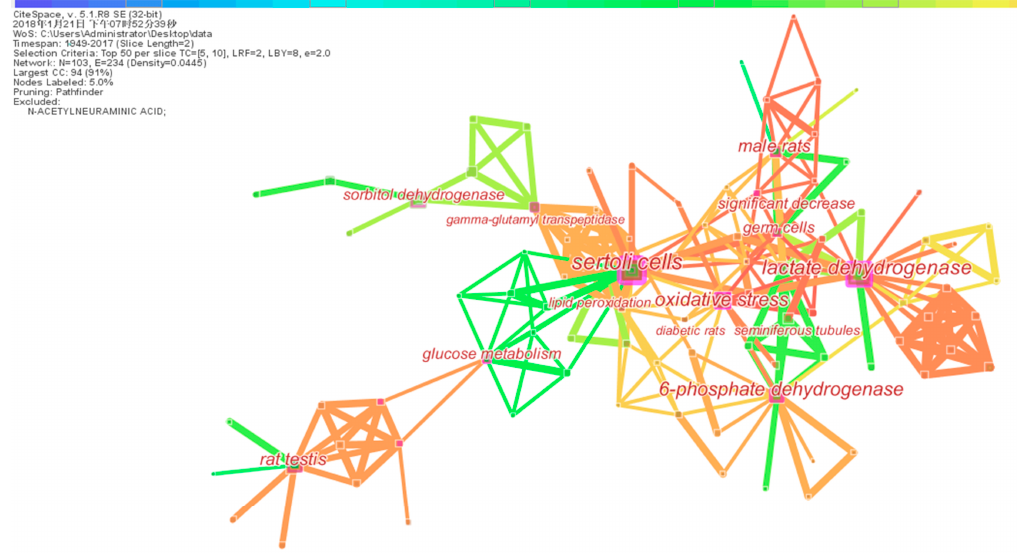
Figure 4. A network of co-words of 165 articles.